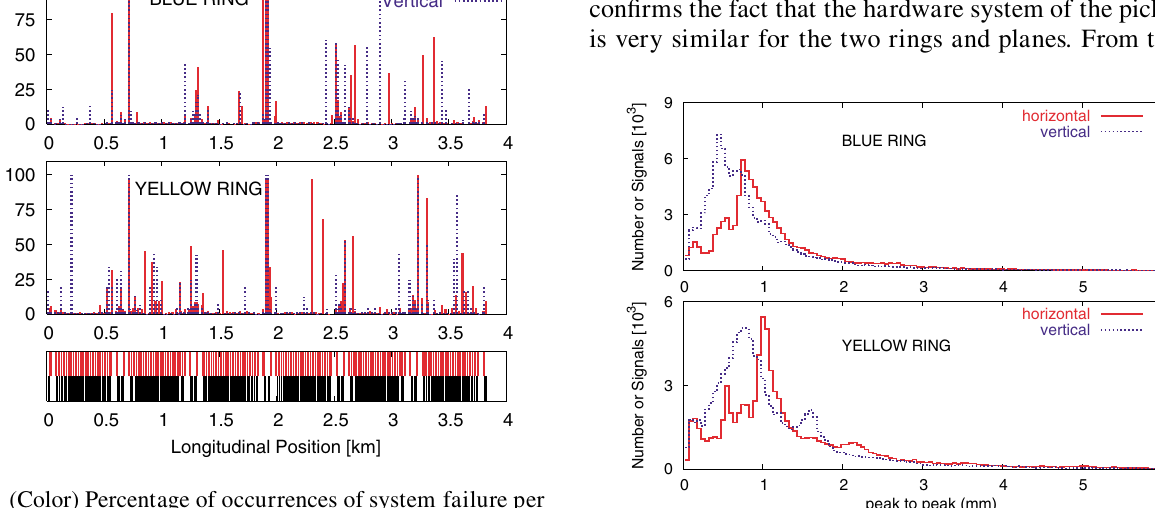
FIG. 4. (Color) Percentage of occurrences of system failure per BPM versus longitudinal location. A representation of the lattice (dipoles in black and quadrupoles in red) is shown in the bottom graph.